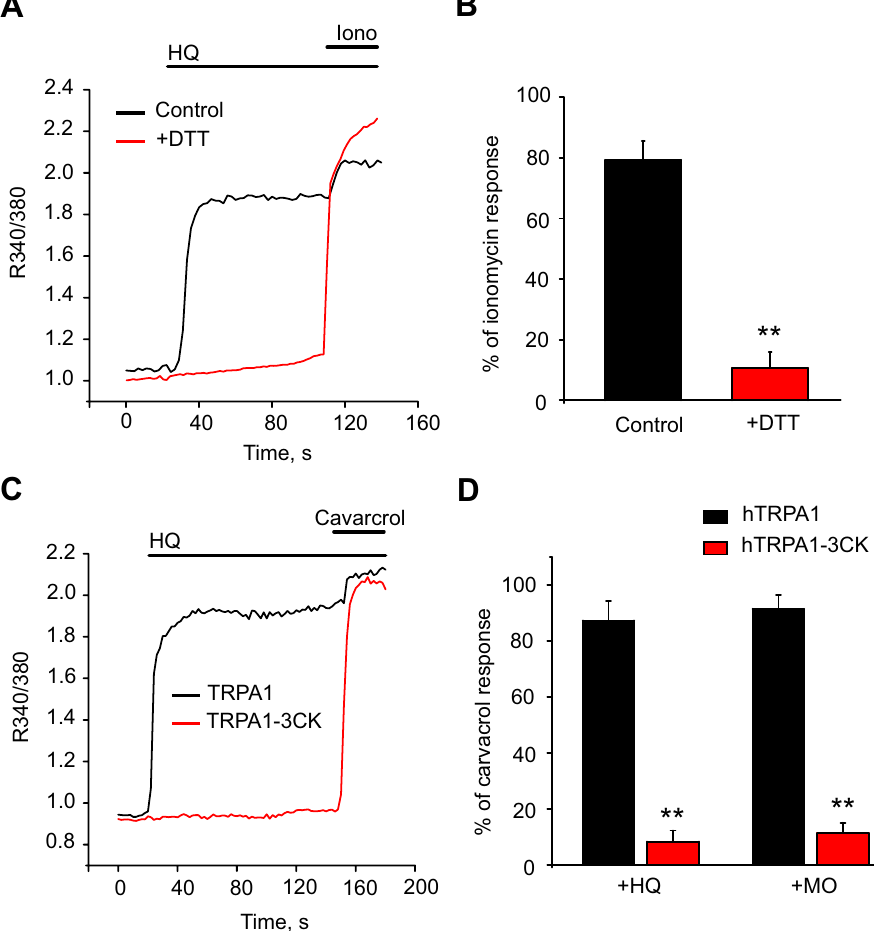
Figure 3. Covalent modification sites of TRPA1 are essential for the effects of HQ. ( A ) Representative Ca 2 + imaging traces showing the effects of reducing reagent DTT on HQ-induced hTRPA1 activation in HEK 293 cells. Cells were pretreated with dithiothreitol (DTT, 3 mM) for 3 min before recording and then recorded under the continued presence of DTT. Cells were challenged with HQ (30 µ M) and subsequently with ionomycin (Iono, 1.5 µ M). ( B ) Summary of the effects of DTT on HQ-induced Ca 2 + responses in HEK 293 cells. n > 40 cells/group. ** p < 0.01 vs . Control group. ( C ) Representative Ca 2 + imaging traces showing responses of hTRPA1 and hTRPA1 mutant (3CK mutant)-expressing HEK293 cells following application of HQ (30 µ M) and carvacrol (300 μ M). ( D ) Averaged Ca 2 + responses induced by HQ and mustard oil (MO, 70 µ M) in hTRPA1 and hTRPA1–3CK. The response was normalized to that of a saturating dose of carvacrol (300 μ M). n > 40 cells/ group. ** p < 0.01 vs . hTRPA1